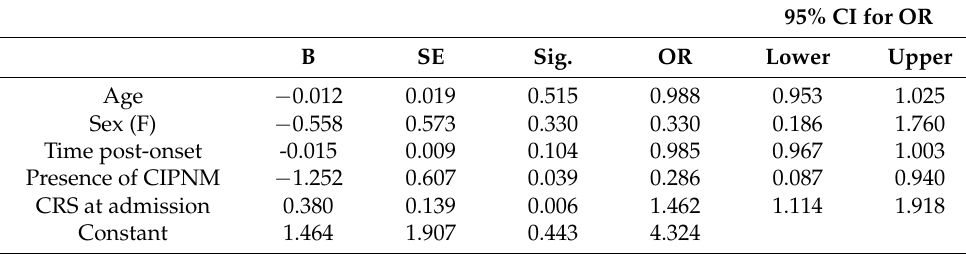
Table 4. Multivariate logistic regression analysis for the UWS